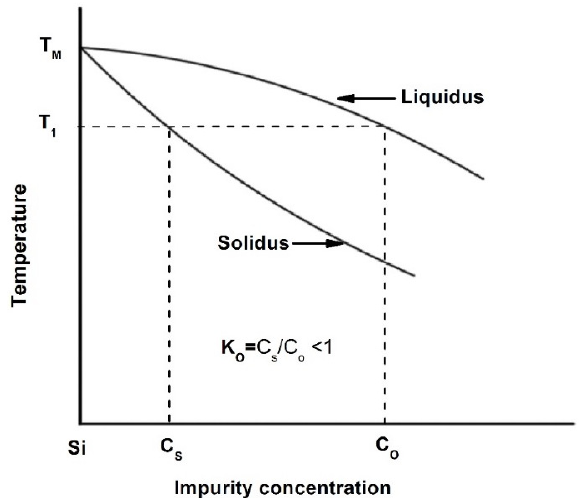
Figure 2. Determination of the distribution coefficient using a phase diagram.